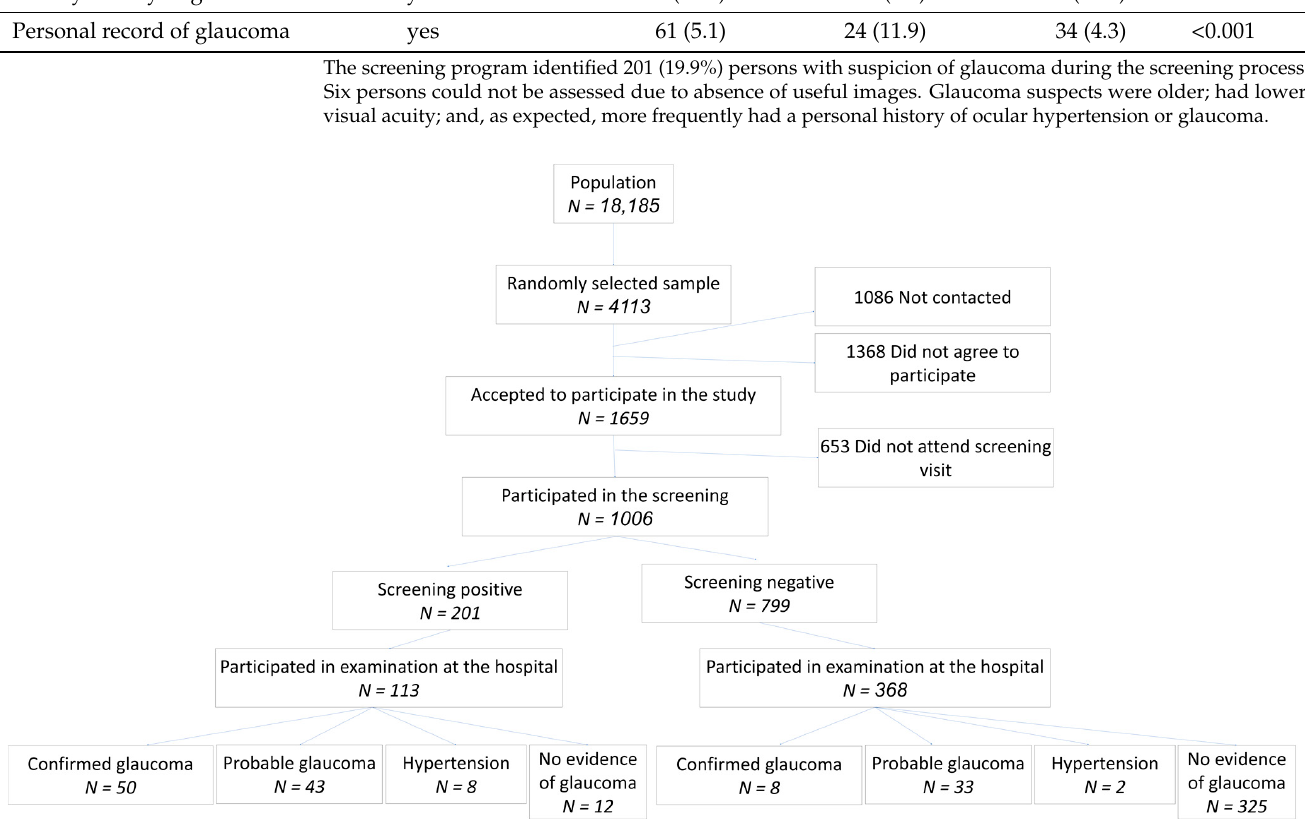
Figure 2. Distribution of the sample through the screening process. Flowchart with distribution of the sample through the screening process and the glaucoma consultation.